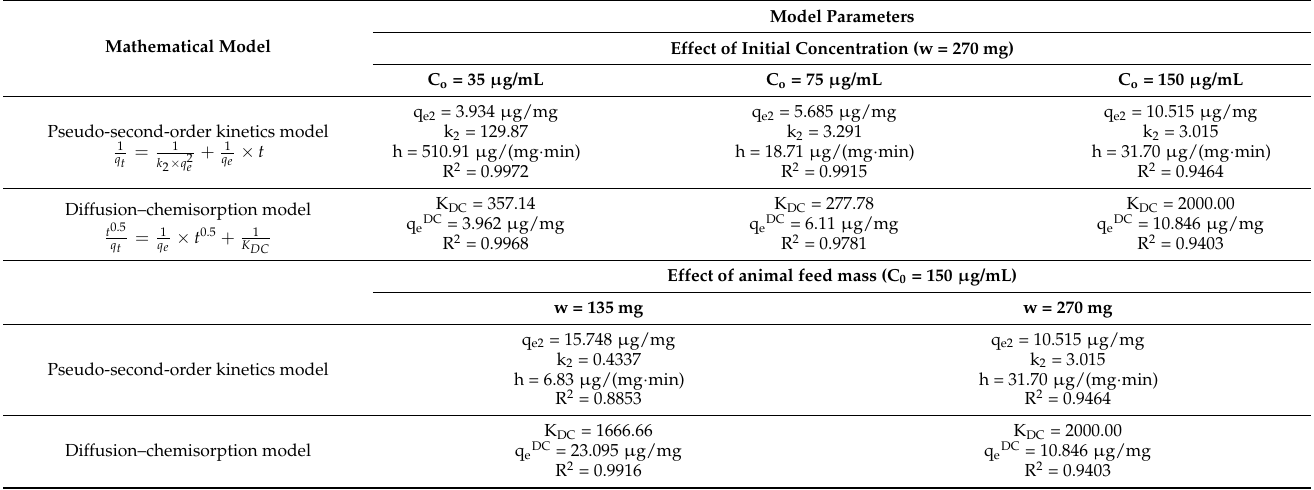
Table 1. Values of the model parameters and error functions of the applied adsorption kinetics models to the system doxycycline/animal